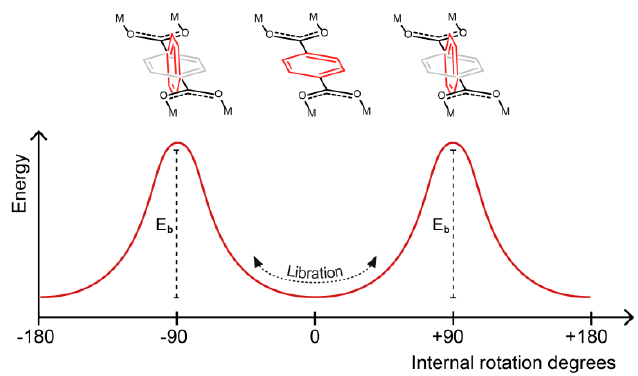
Figure 2. Torsional potential curve of a terephthalate rotor.